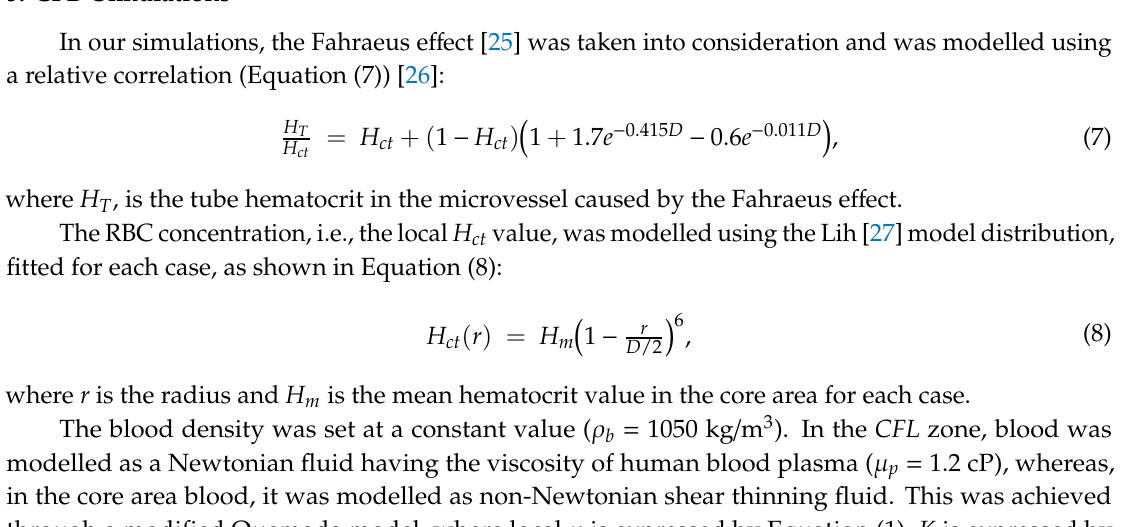
Figure 13. Comparison of Equation (6) with Reinke et al.’s [24] experimental data for CFL thickness (10% error bars).